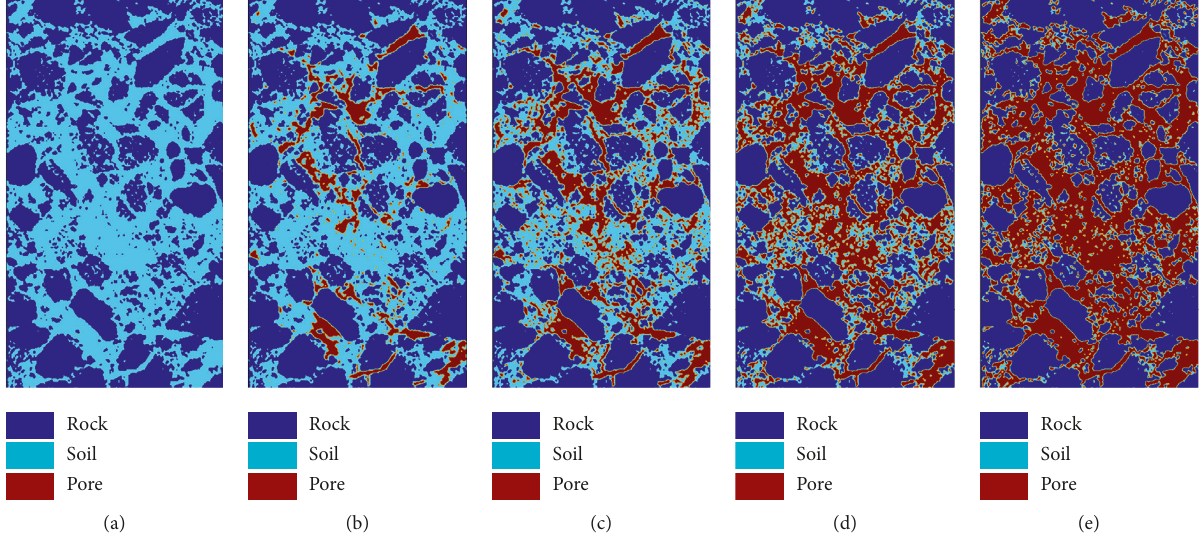
Figure 8: Numerical model of A-1 to A-5 samples.